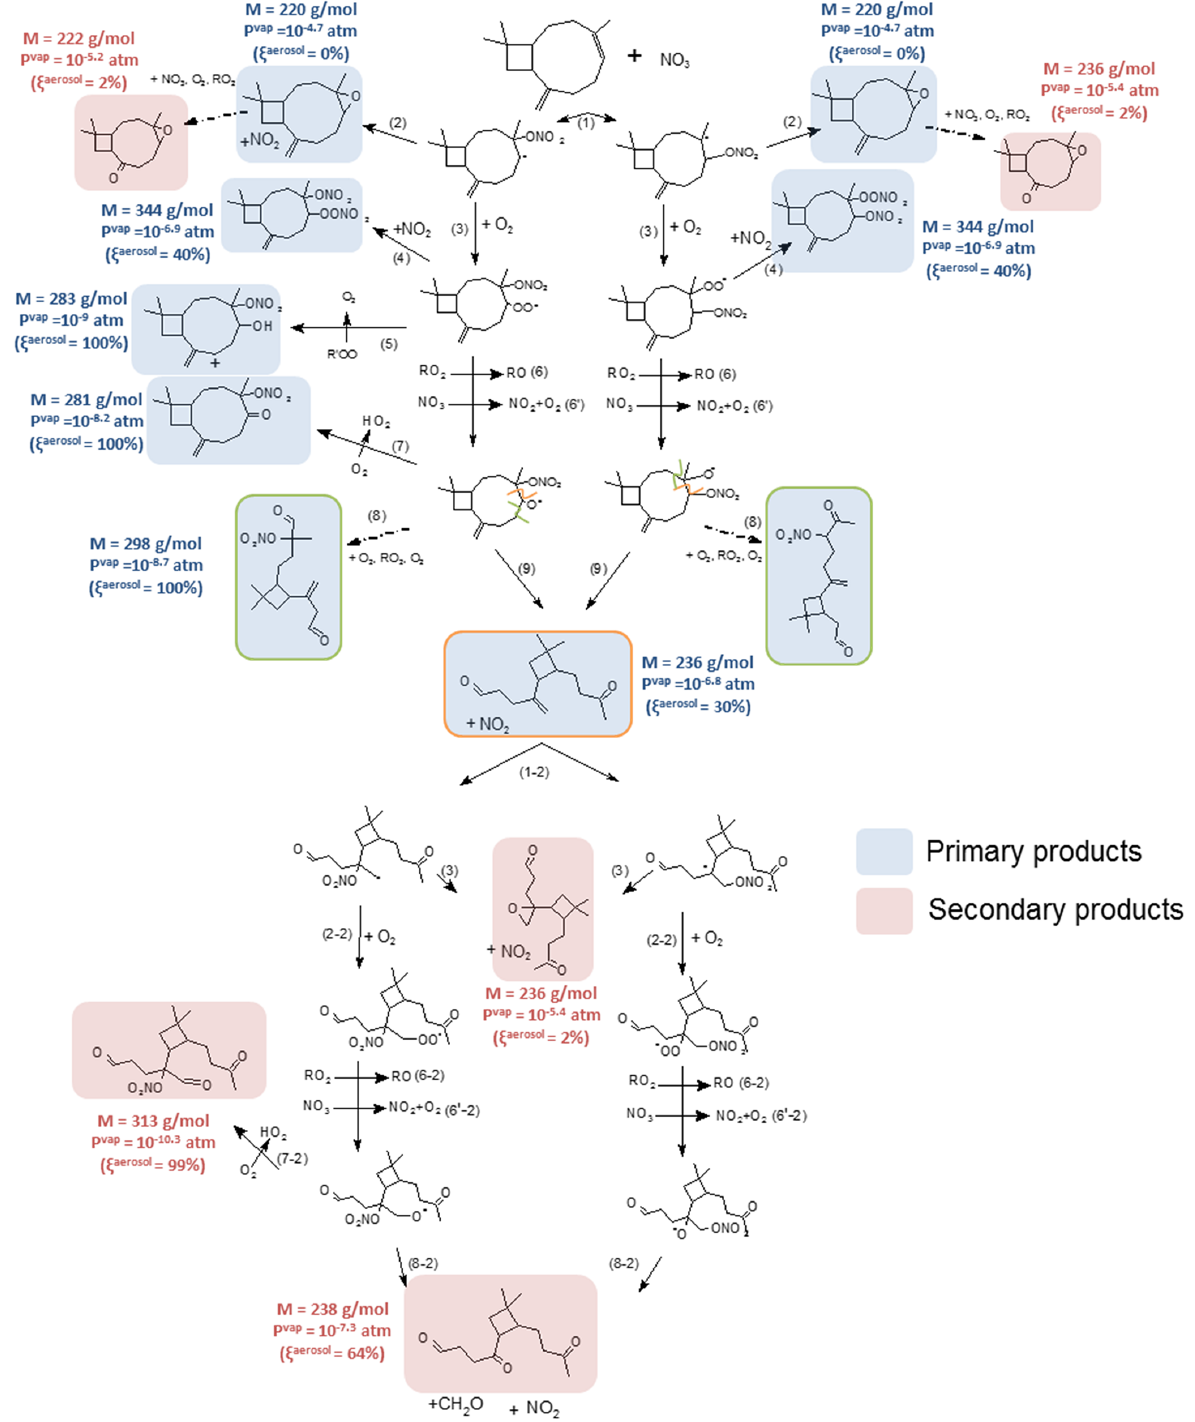
Figure 9. Proposed mechanism for β -caryophyllene. First-generation products are squared in blue and second-generation ones in red. Alkoxy fragmentation products are squared according to the location of the fragmentation. Molecular weight, vapor pressures and the gas–particle partition are shown next to the